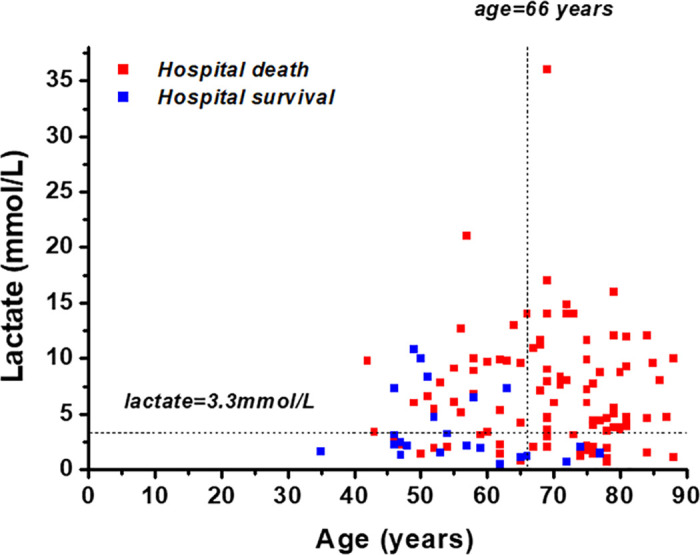
Scatter plot of age, lactate and survival.Scatter plot of both in hospital survivors (blue) and deceased patients (red) in relation to age and lactate levels. The raw data is accessible in the supporting information (S1 Table).